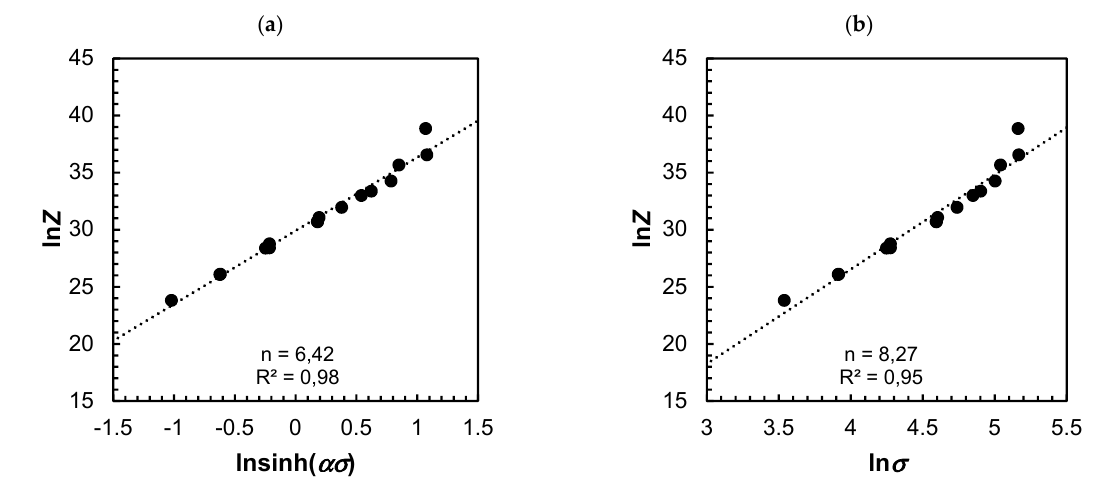
Figure 10. Relationship between ( a ) lnZ–ln[sinh( α · σ )] and ( b ) lnZ–ln 𝜎.